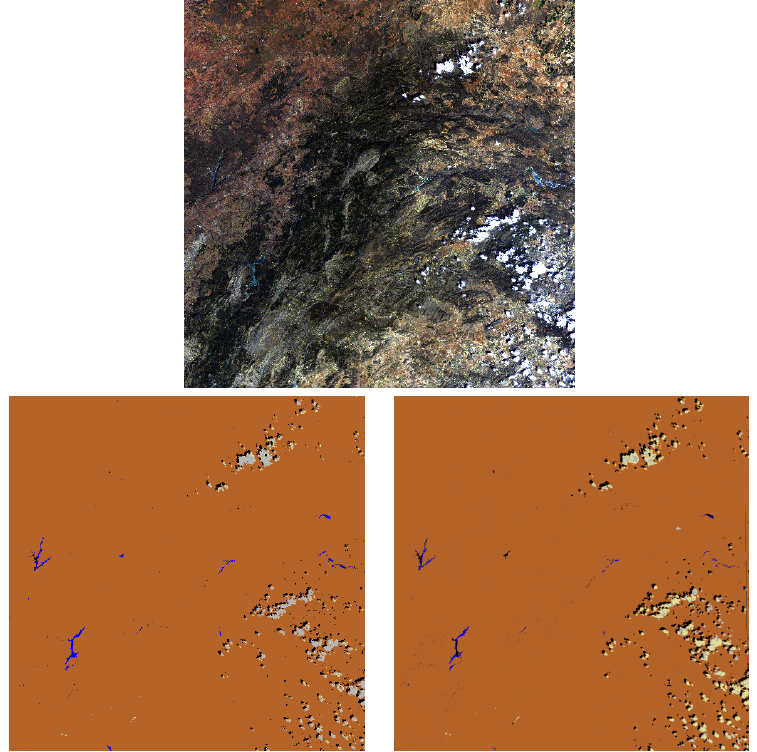
Figure 3. Top row: true color (RGB = 665, 560, 443nm) composite of scene ID 18 (Barrax-2). Bottom row ( left to right ): ATCOR and PACO classification maps (with clear (brown), cloud (grey), water (blue), shadow (black) and cirrus cloud (yellow)